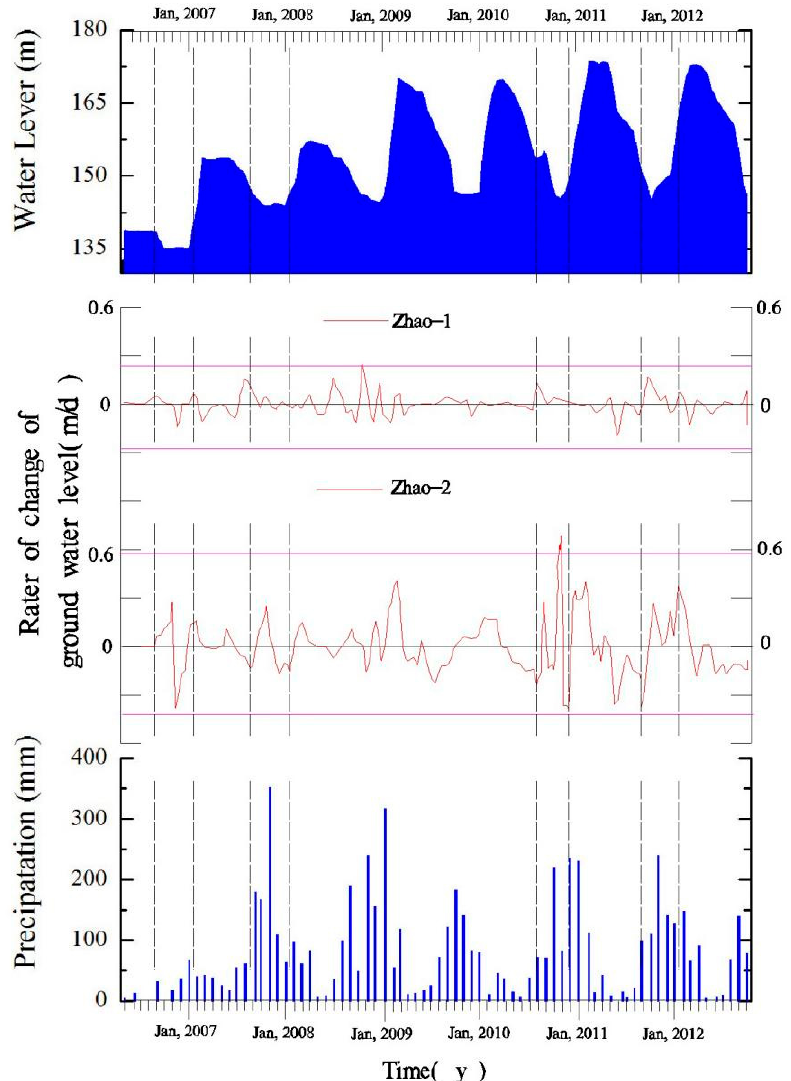
Figure 18. Relationships between the precipitation and the changes in the rates of the ground water levels in the Zhao-1 and Zhao-2 boreholes.